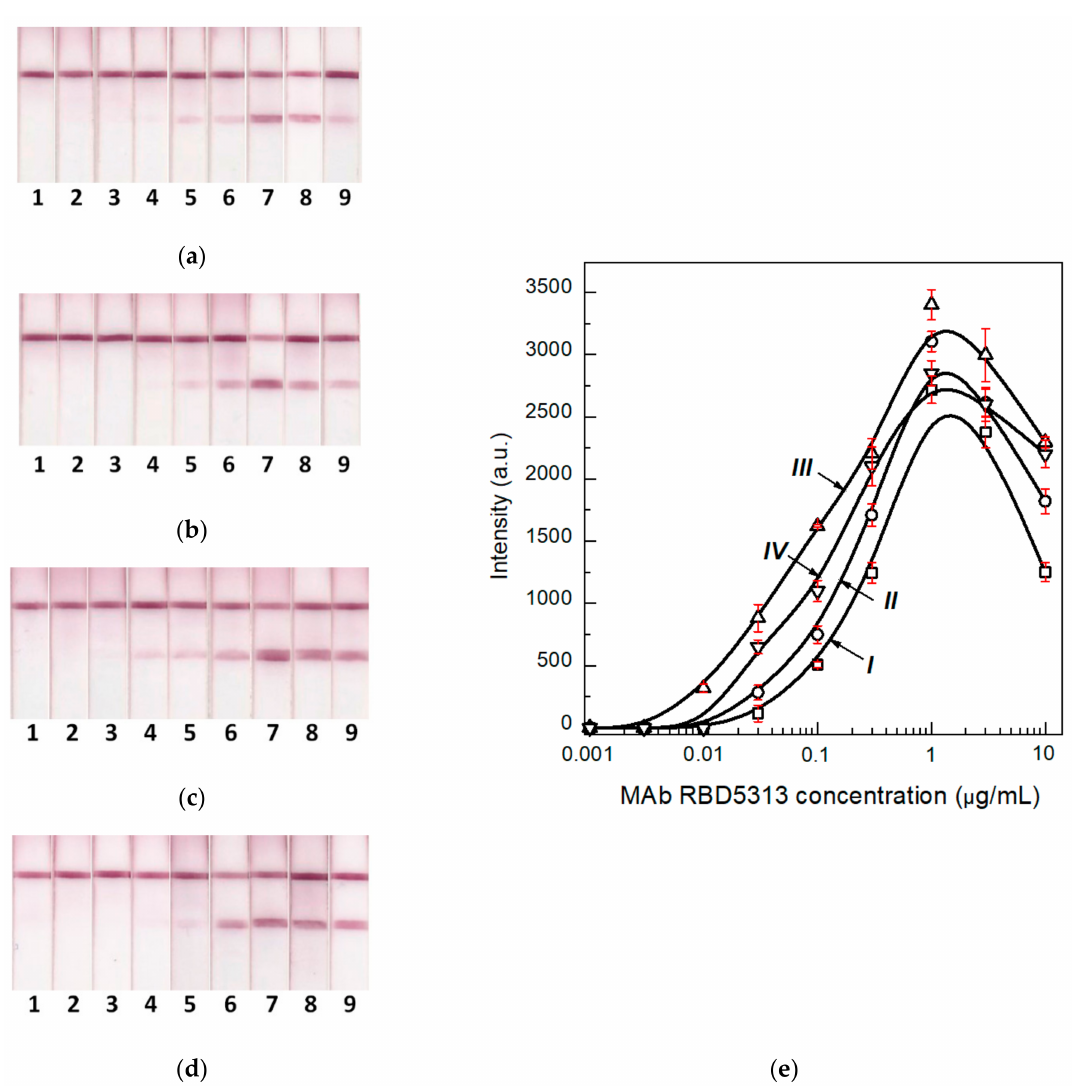
Figure 6. Images of test strips manufactured with the pA–GNP conjugate with OD 520 = 2 ( a ), 5 ( b ), 10 ( c ), and 20 ( d ) after LFIA of samples containing 0 (1), 0.003 (2), 0.01 (3), 0.03 (4), 0.1 (5), 0.3 (6), 1 (7), 3 (8), and 10 (9) ng/mL of MAb RBD5313. ( e ) Concentration dependence for test systems containing the pA–GNP conjugate with OD 520 = 2 (I), 5 (II), 10 (III), and 20 (IV) ( n = 3). 3.7. Testing of the Developed LFIAs on Blood Samples of Patients with a Confirmed COVID-19